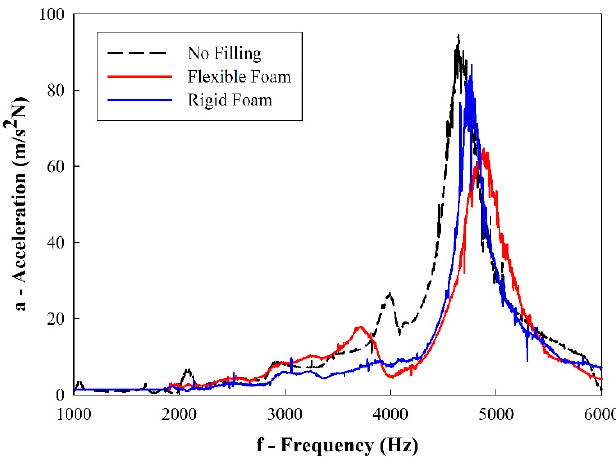
Figure 7. Sample frequency response function (FRF) from the vibration testing.